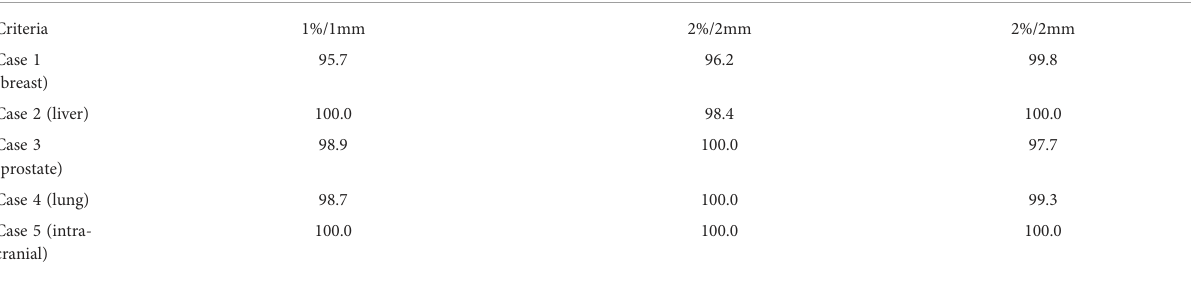
TABLE 7 2D Gamma passing rate (%) for IMRT plan veri fi cation of fi ve clinical cases (actual TB-10MV measurement vs synthesized 10MV